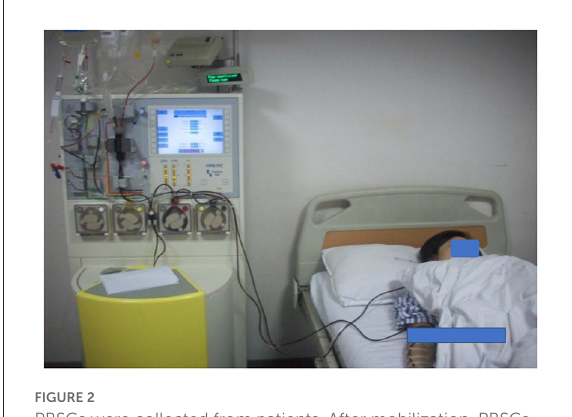
FIGURE2 PBSCs were collected from patients. After mobilization, PBSCs were harvested from peripheral circulation of the patient by apheresis technique using COBE spectra apheresis system (COBE BCT Inc, Lakewood, CO, USA) according to the mononuclear cell collection procedure as recommended in the